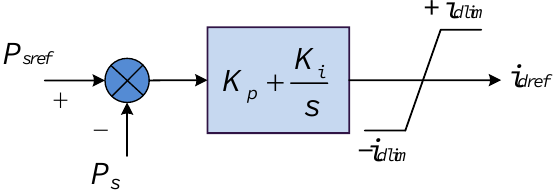
Figure 3. The detailed outer controls of the active power control.